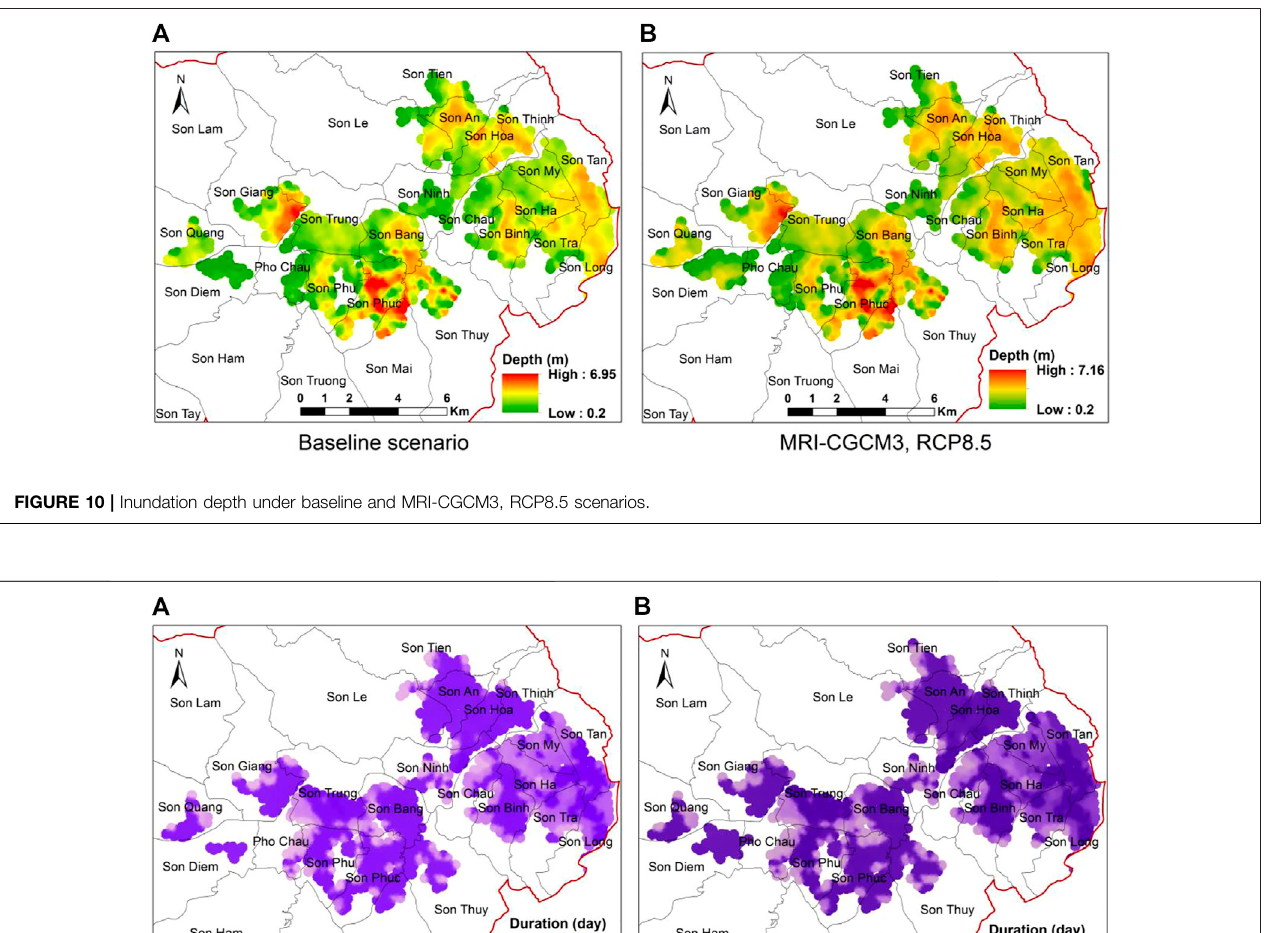
Frontiers in Environmental Science |